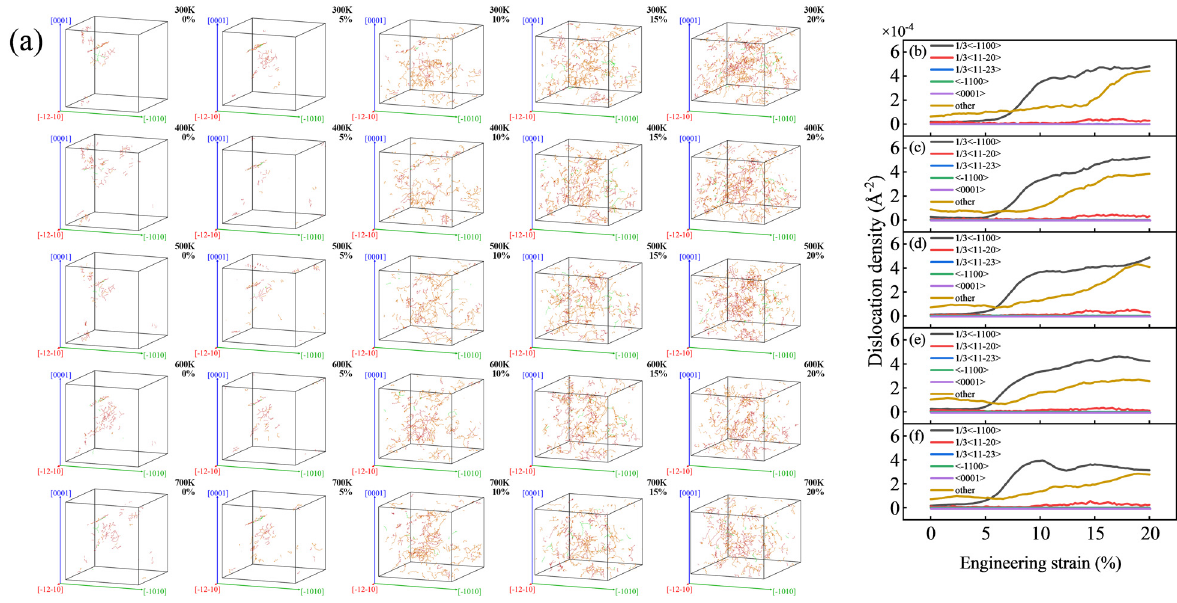
Figure 15: Dislocation evolution: ( a ) dislocation line diagram and ( b ) – ( f ) dislocation density curve.